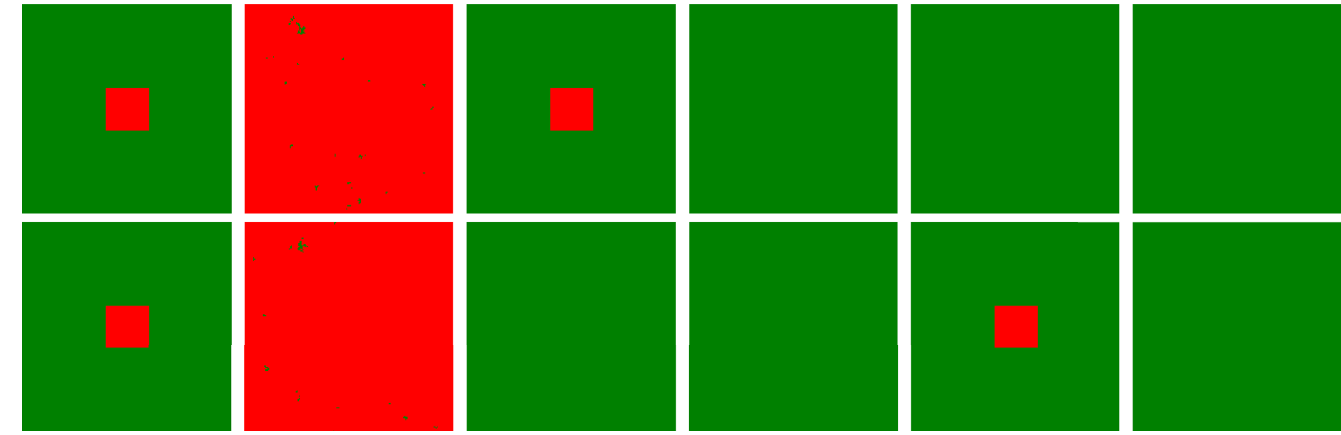
Fig 4. For a specific initial setup, characteristic patterns between cooperators and defectors on two interdependent lattices at MCS = 1 and MCS = 50000 under case I. In all panels, red dots represent cooperators and green dot denote defectors. For the left four panels, central cooperators are initially set on upper and lower lattices at the same time; only cooperators exist on the center of upper lattices in the middle four panels; while cooperators merely exist on the center of lower lattices in the right four panels. However, the coupling strength for each pair of players on two lattices is set to be equal, in which the coupling strength is taken from Eq (2). It is clearly indicated that cooperative pairs support the emergence of cooperation on interdependent networks. From left to right, the only difference lies that initial conditions are set as different parameter deployments between cooperators and defectors. The simulation parameters are set as follows: MCS = 50000, b = 1.05, L = 200, K = 0.1 and A = 0.5.